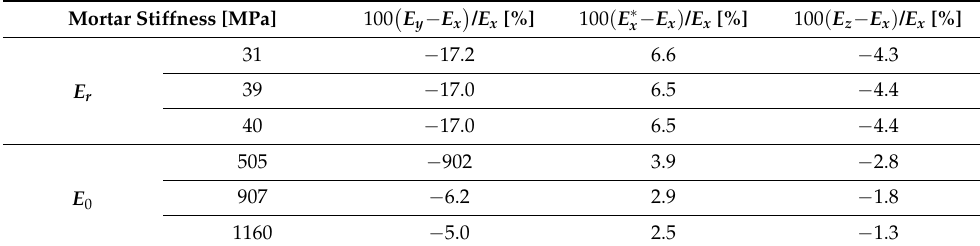
Table 6. The percentage difference between values of the particular effective stiffness moduli and the E x modulus for different mortar material parameters ( ν = 0.4). Mortar Stiffness [MPa] 100 (cid:0) E y − E x (cid:1) / E x [%]